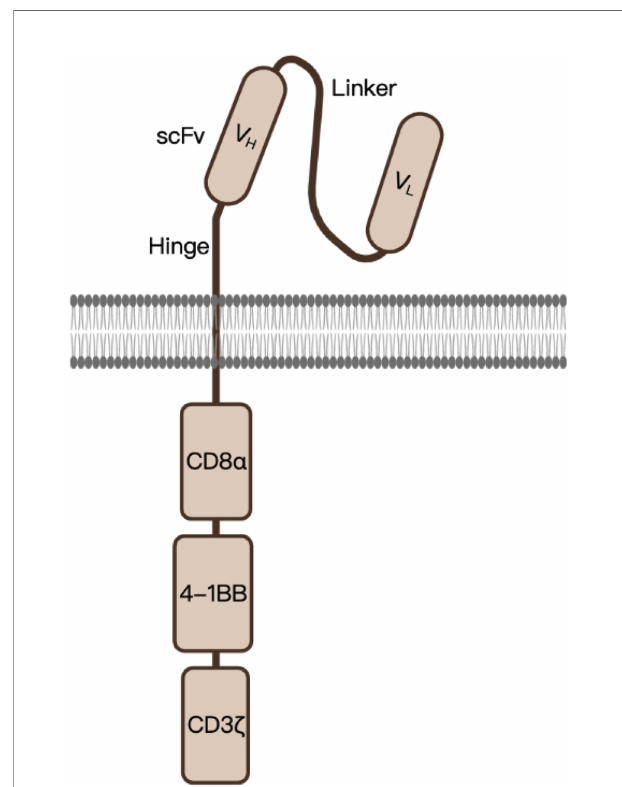
FIGURE 1 | A schematic diagram of anti-BCMA CAR design. scFv, single- chain variable fragment, serving as the BCMA-recognition domain; CD8 a , in which the hinge (transmembrane domain) was derived; 4-1BB, co-stimulatory domain which enhances the function of CAR; CD3 z , serves as the signal- transduction